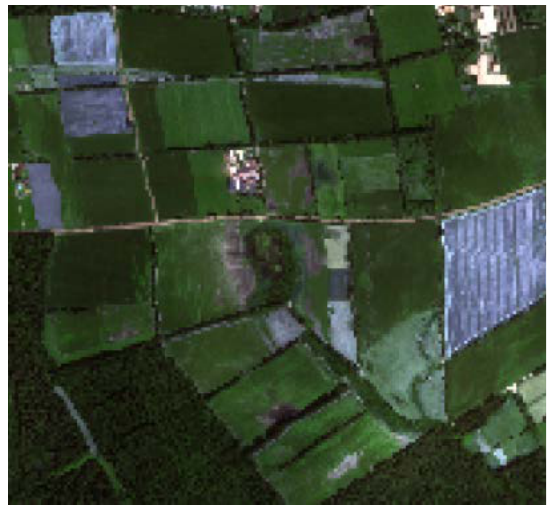
Figure 5. Simulated RGB data set representing the Sentinel-2 bands 2 to 4. The scene is spatially and temporally identical to Figures 2 and 3. The spatial resolution here is